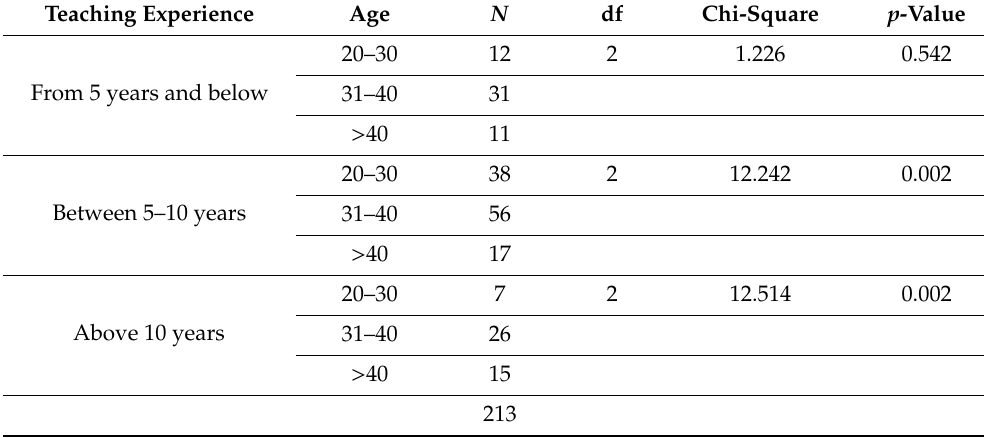
Table 9. Kruskal–Wallis Test for social belief (age with teaching experience).